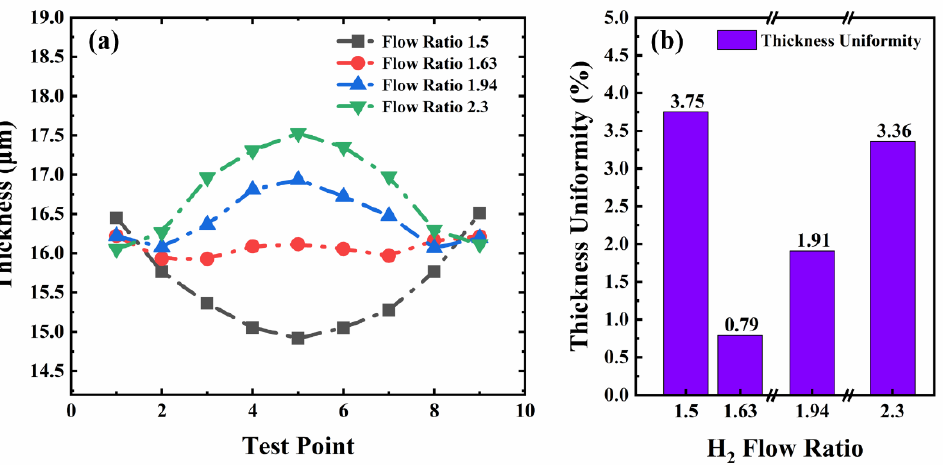
Figure 5. Influence of H 2 flow ratio on: ( a ) radial distribution and ( b ) uniformity of the wafer thick- ness.